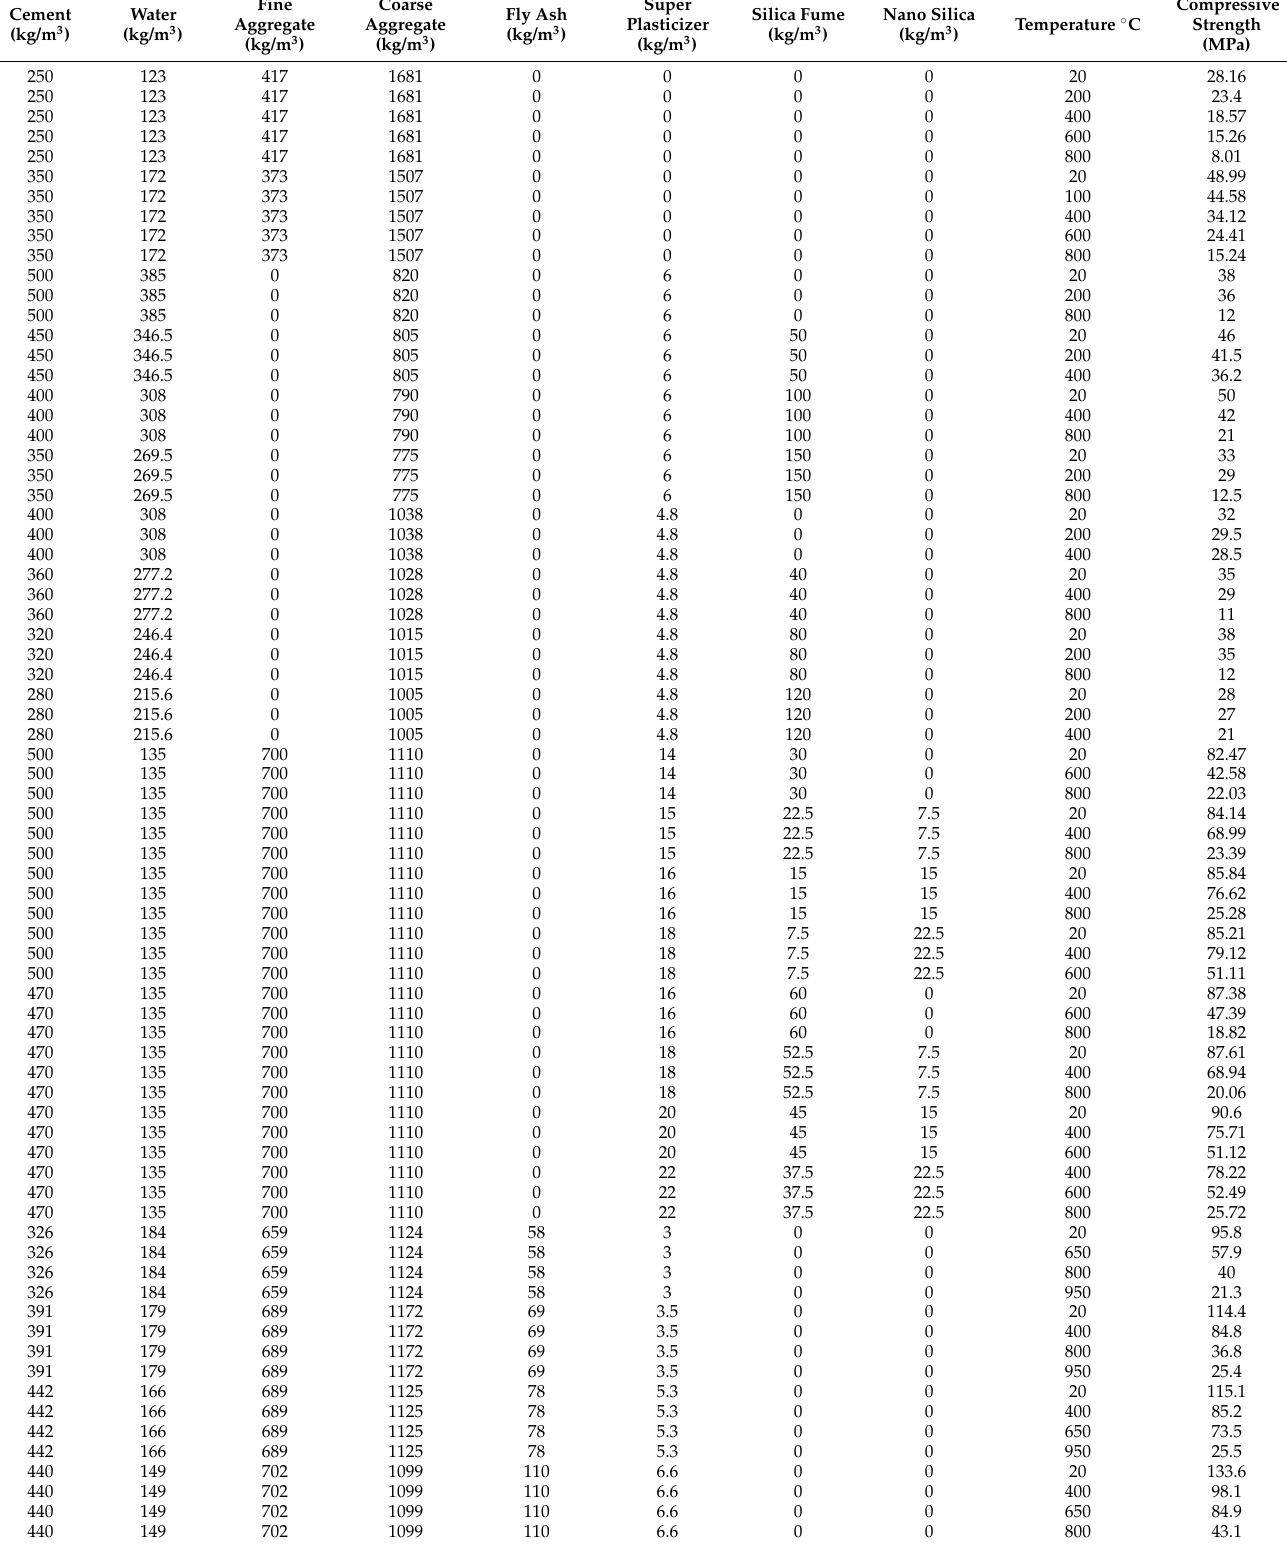
Table A1. Data points used in